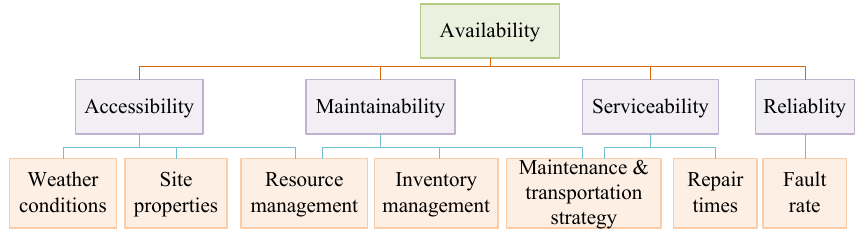
Figure 20. Main influential factors in the maintenance of offshore wind farms.